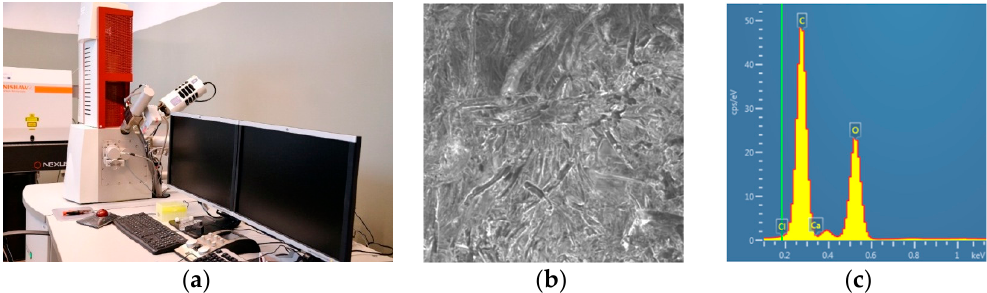
Figure 3. Scanning electron microscope and spectral analysis of the MDF: ( a ) Measuring stand; ( b ) microphotograph of an MDF panel surface; ( c ) spectra of the outer surface of an MDF panel.